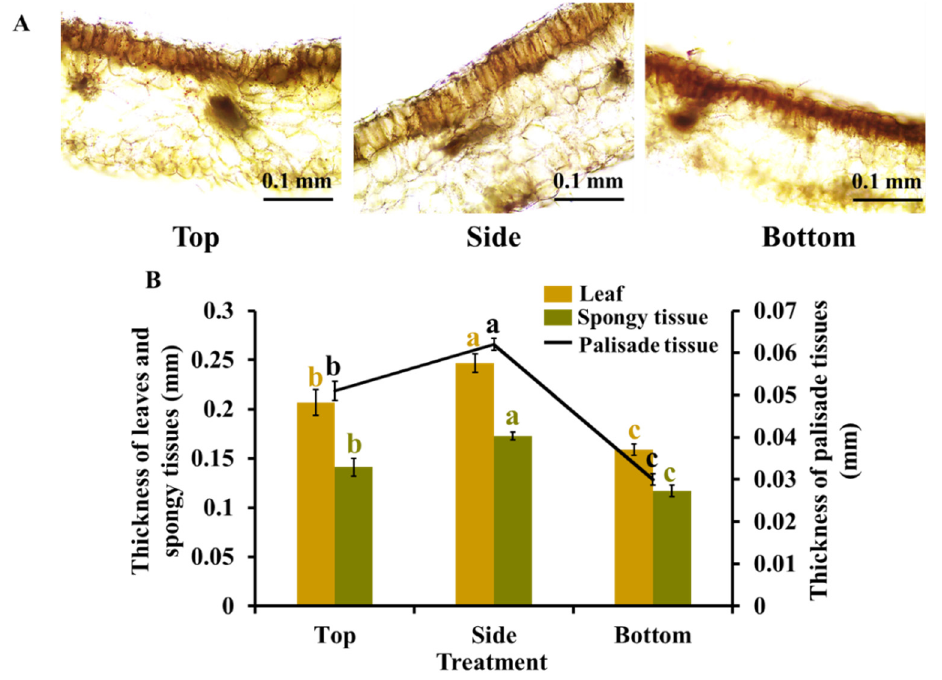
Figure 2. Changes in the leaf structure of strawberry ‘Sulhyang’ plants as affected by the lighting direction after 45 days of cultivation. Pictorial representation of the leaf structure ( A ), leaf, spongy tissue, and palisade tissue thickness ( B ). Vertical bars indicate the means ± standard error ( n = 6). Different lowercase letters indicate the significant separation within treatments by Duncan’s multiple range test at p ≤ 0.05. Bars indicate 0.1 mm.